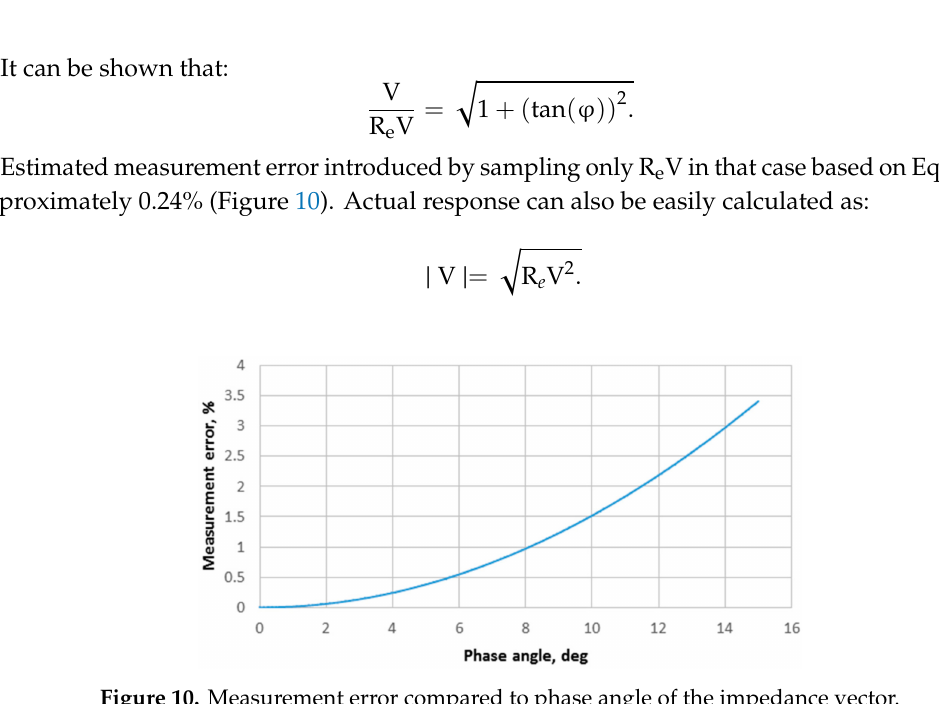
Figure 10. Measurement error compared to phase angle of the impedance vector.